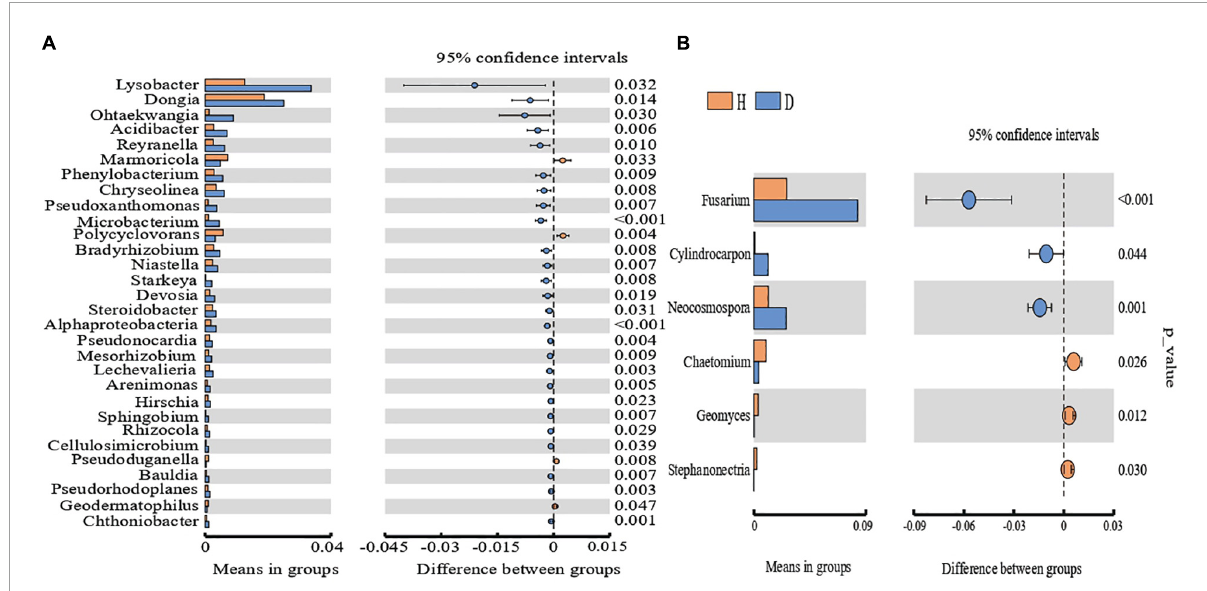
FIGURE2 The difference in the relative abundance of bacteria (A) and fungi (B) between healthy and diseased plants was calculated, and the t -test was used to calculate the P -value ( P < 0.05). H and D refer to healthy and diseased plant